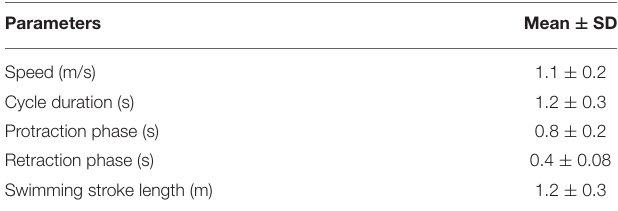
TABLE 1 | Hindlimb stride parameters in horses during free (untethered) swimming ( n =